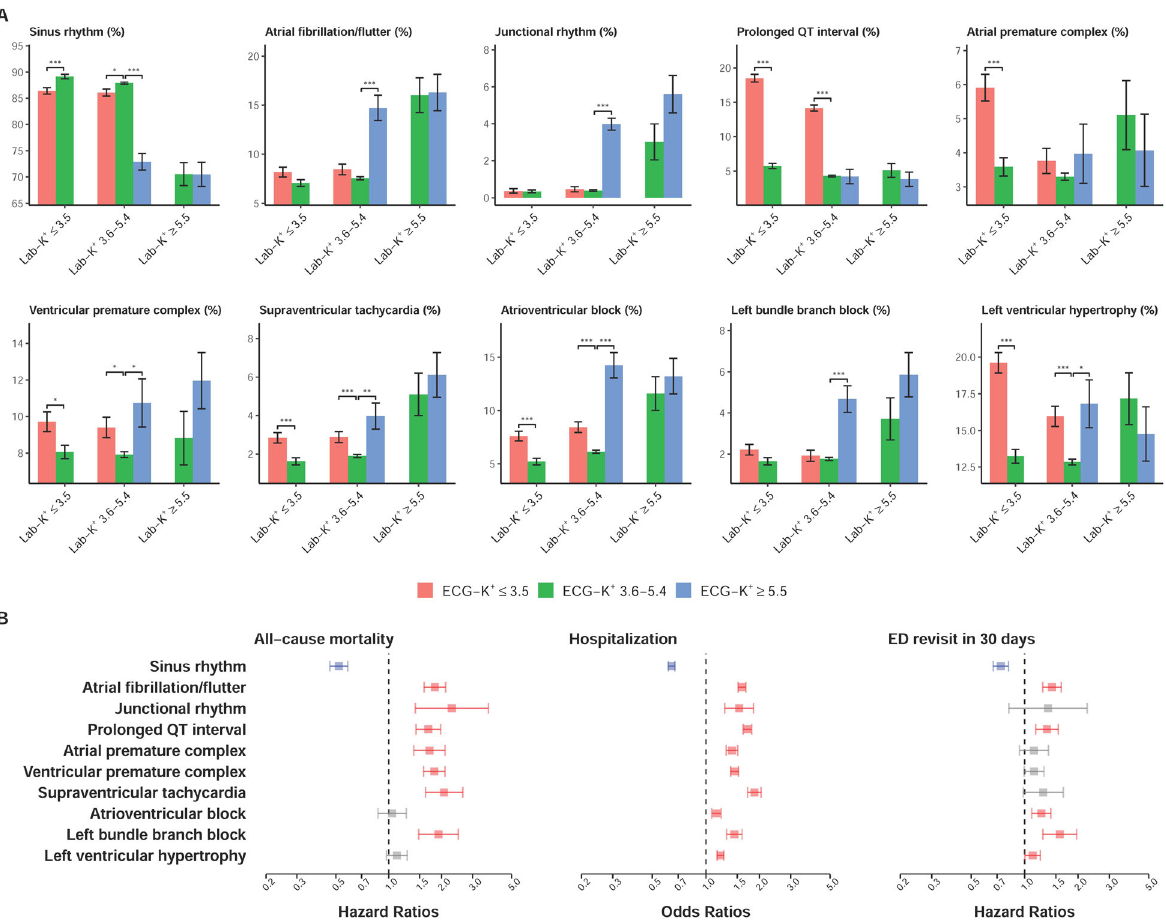
Fig. 7 ECG morphology analysis of combinations of ECG-K + and Lab-K + on adverse outcomes. A Distributions of ECG morphology in each ECG-K + and Lab-K + group. Bars represent the mean or prevalence where appropriate and corresponding 95% conference intervals, which are adjusted by hospital. B Risk analysis of selected ECG morphologies on adverse outcomes. The hazard ratios and odds ratios were adjusted by hospital. Red, gray, and blue bars denote signi fi cantly positive, non-signi fi cant, and negative associations, respectively, with the corresponding